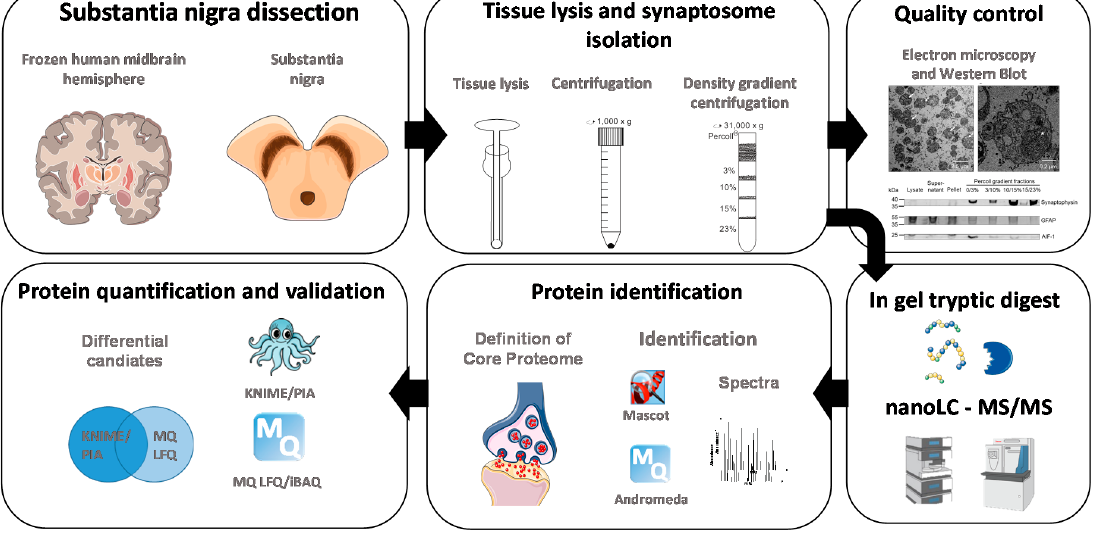
Figure 1. Strategy for the characterization of synaptosomes. Substantia nigra pars compacta (SNpc) was dissected from fresh frozen postmortem human midbrain tissue. The SNpc of one midbrain hemisphere of each case was lysed separately and the Dounce homogenizer was cleaned before each tissue lysis. Lysates were centrifuged separately, and supernatants were fractionated by separate density gradients. With electron microscopy and Western blot, interphase 15 to 23% Percoll was identified as the fraction with the highest purity regarding synaptosomes. Hence, synaptosomes enriched in this fraction were digested in gel by trypsin and resulting peptides were fractionated and analyzed by nanoLC-MS / MS. Resulting spectra were assessed by two di ff erent algorithms—Mascot and Andromeda. Resulting identifications were compared and only proteins that were identified with both algorithms in all analyzed samples were accepted as part of the core proteome in synaptosomes isolated from the SNpc. Further, identified proteins were quantified using spectral counting and MaxQuant (MQ) label free quantification (LFQ). Resulting candidates were compared leading to the identification of unique candidates.